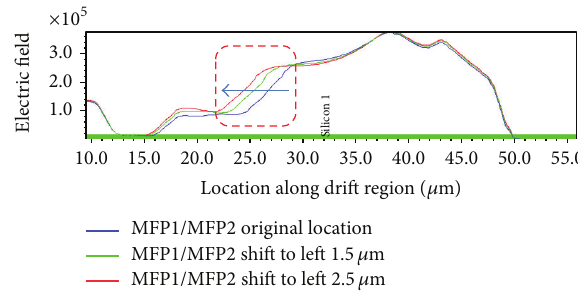
Figure 4: Lateral electric field distribution of different MFP2 location.